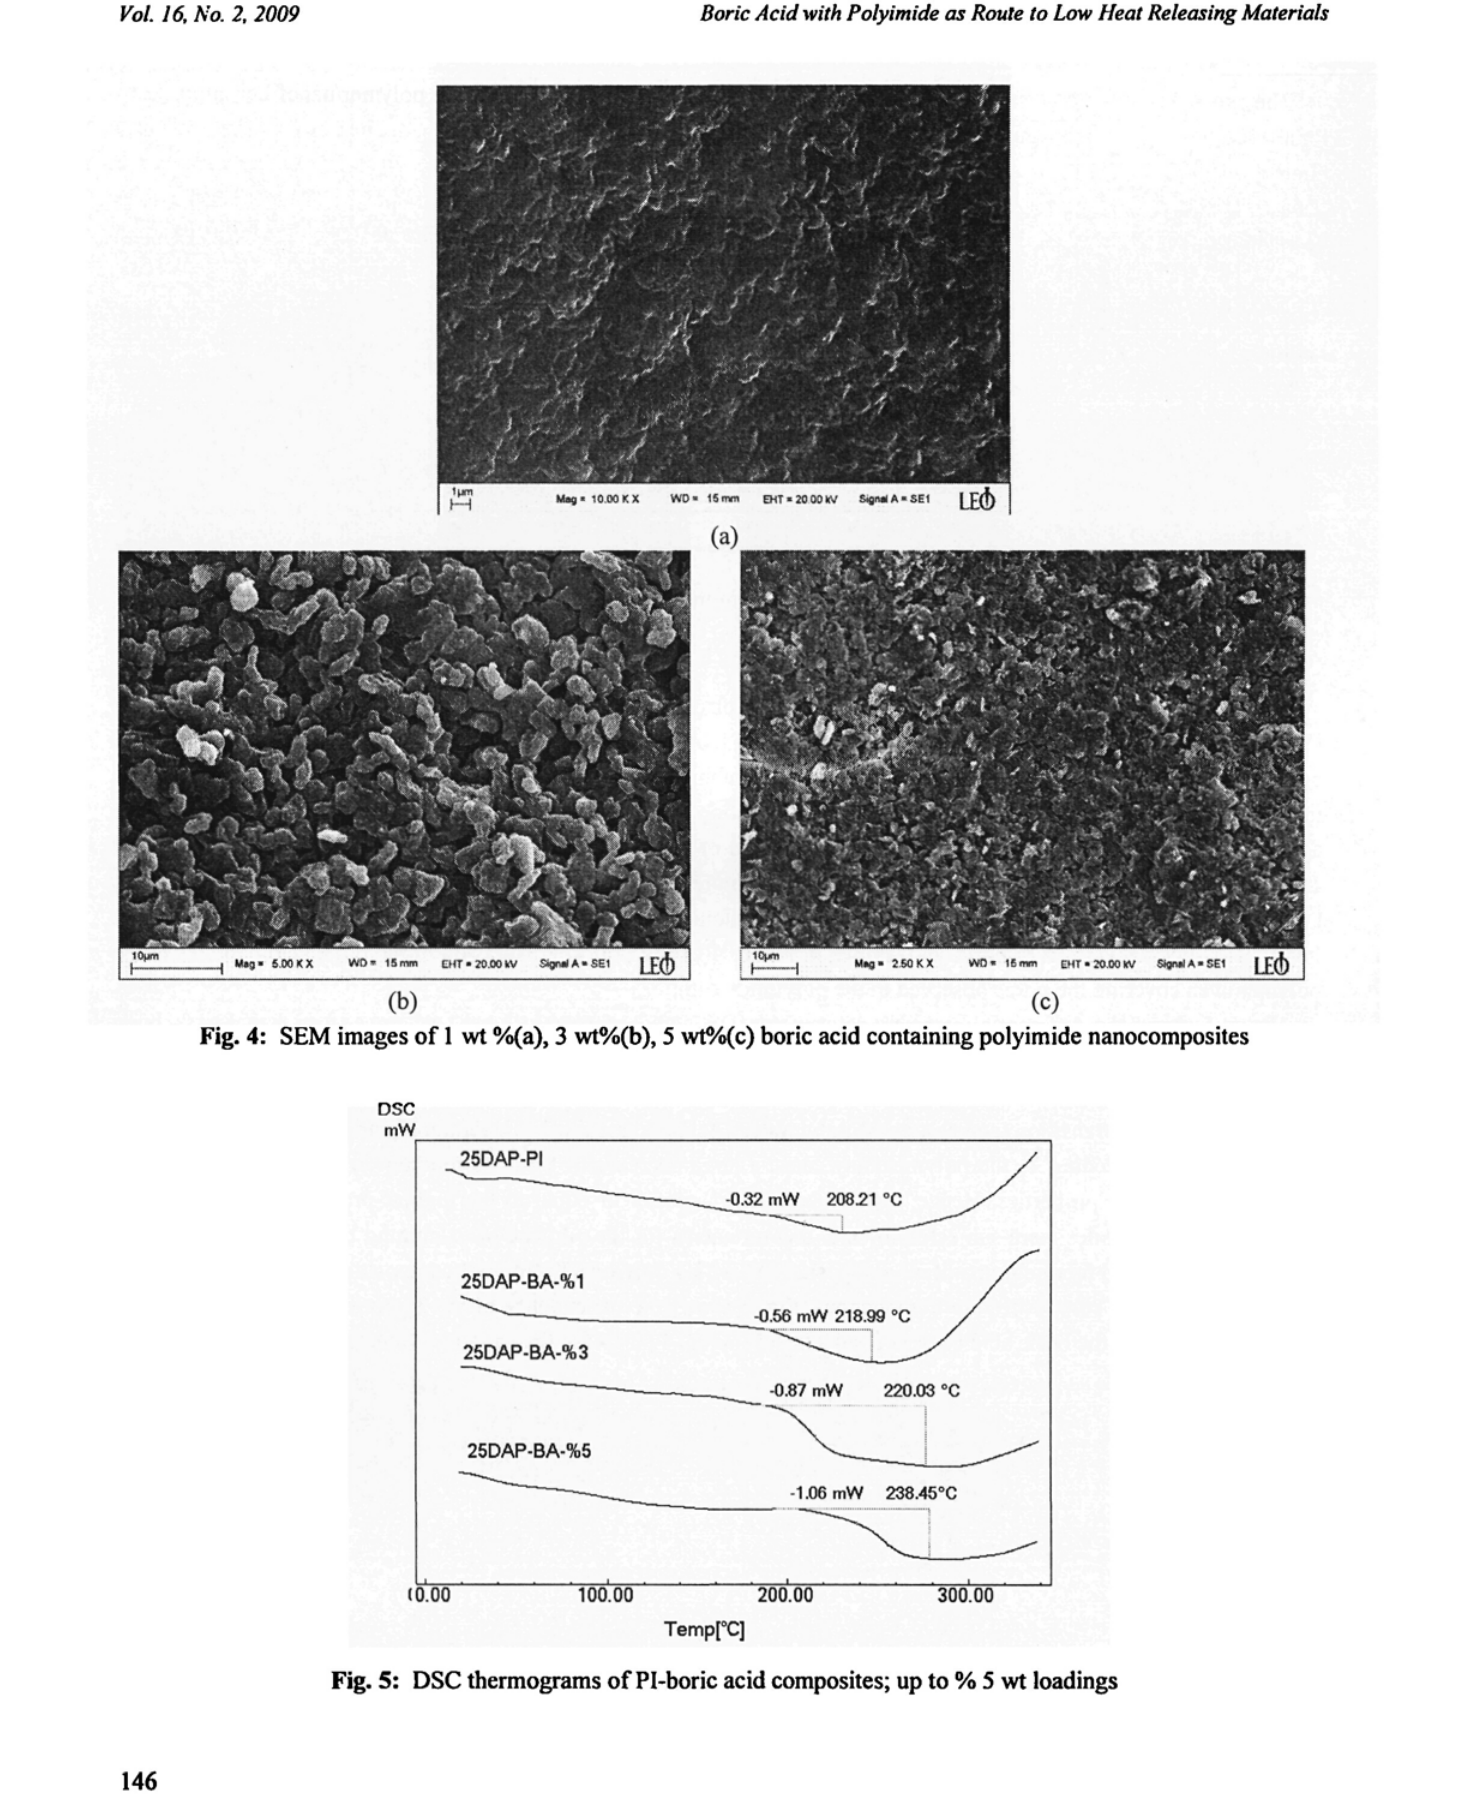
Fig. 5: DSC thermograms of Pi-boric acid composites; up to % 5 wt